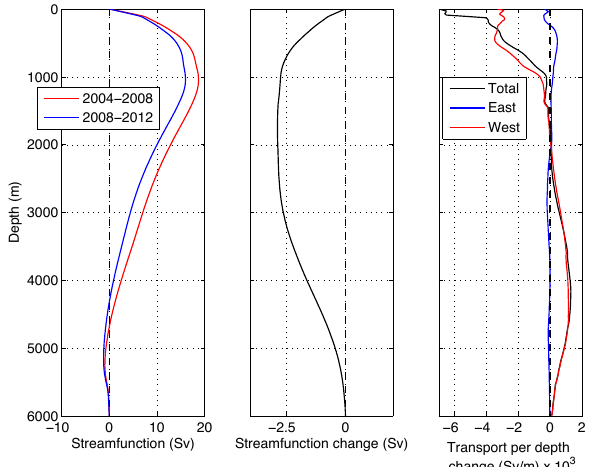
Fig. 4. Left: mean stream function profile (Sv) for the two four-year periods April 2004 to March 2008 and April 2008 to March 2012. Centre: difference between the two profiles in the left hand plot. Right: change of the transport per depth profiles (Svm − 1 ) between the two four-year periods, positive values correspond to northward flow. Black shows total change in transport per depth, blue shows that part due to changes on the eastern boundary and red shows that part of the change due to changes on the western boundary. Note that the black curve includes changes of Ekman and Gulf Stream transports and a small contribution form changes of density adjacent to the mid-Atlantic